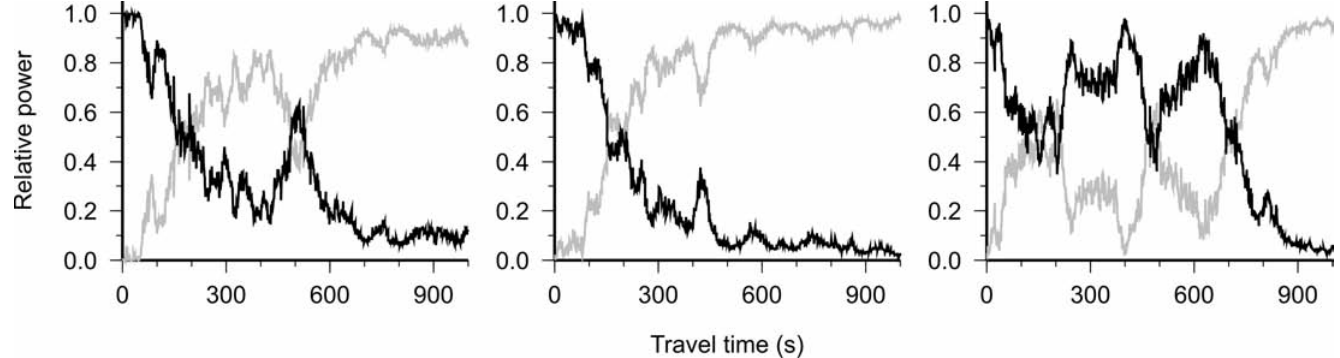
. Black and gray lines show the N